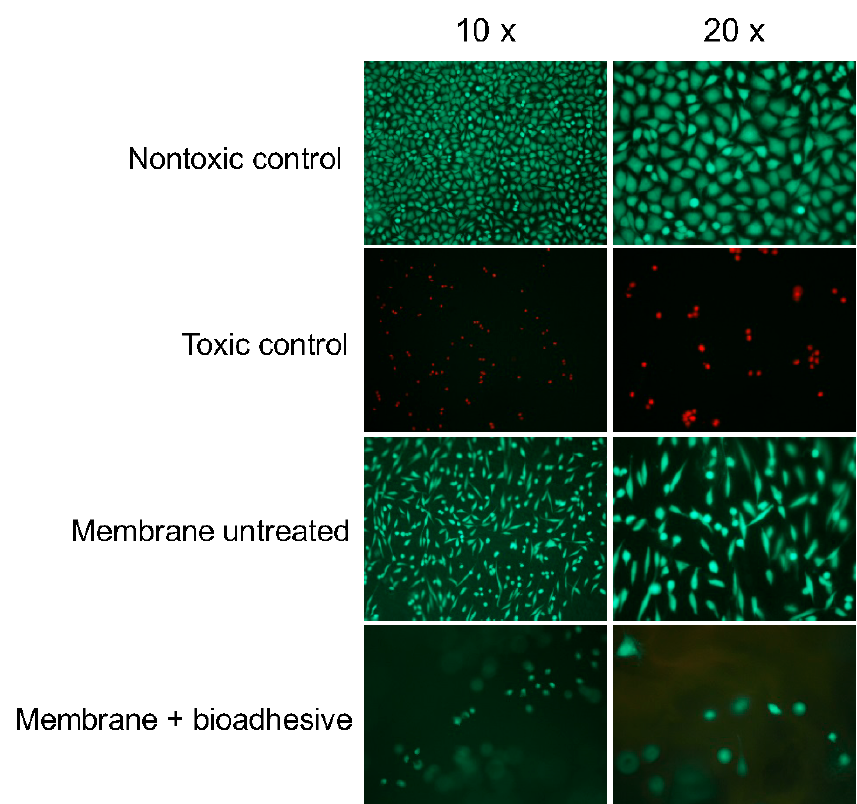
Figure 4. L929 cells grown on the collagen membrane and on the laser-welded membrane + bioadhesive. Vital and dead cells show green and red fluorescence, respectively. Fewer cells on the laser-welded membrane and lack of focus were due to laser-induced unevenness of surface.